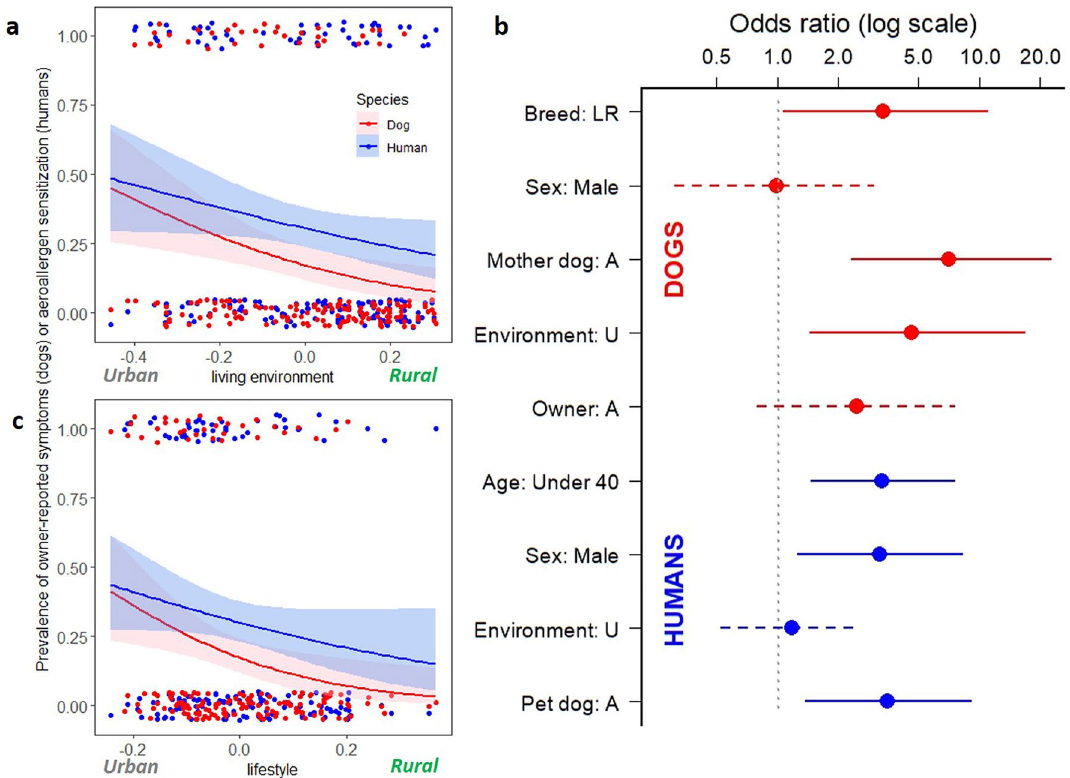
Figure 1. The association between living environment and lifestyle with allergic traits in dogs and humans. In dogs, both ( a ) living environment and ( c ) lifestyle associate with the prevalence of owner-reported allergic symptoms (logistic regression, p = 0.003 and p = 0.007, respectively) while in humans living environment and lifestyle showed borderline association with aeroallergen sensitization (p = 0.054 and p = 0.093, respectively). ( b ) Shows adjusted odds ratios from logistic regression separately for dogs and humans. Each explanatory variable is adjusted for other variables mentioned in the figure, separately for dogs and humans. Bars indicate the confidence intervals. Dashed bars indicate insignificant association between exposure and outcome in adjusted analysis. Breed: LR = breed of dog is Labrador’s Retriever, Sex: Male = Individual is male, Mother dog: A = dog’s mother is allergic, Environment: U = living environment of individual is urban, Owner: A = owner of a dog is sensitized, Age: Under 40 = human is younger than 40 years, and Pet dog: A = pet dog suffers from owner- reported allergy